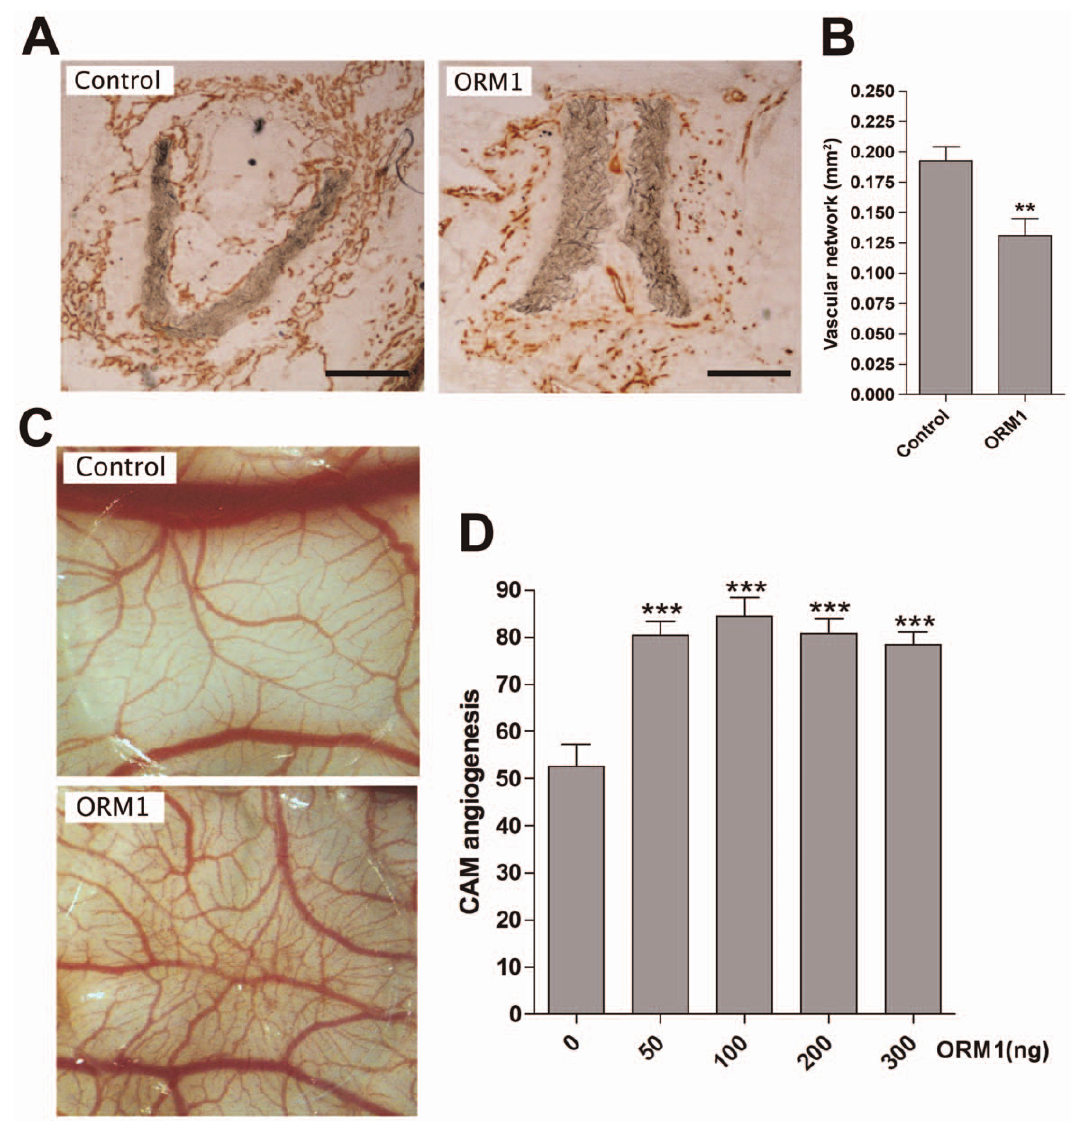
Figure 7. Effect of ORM1 on angiogenesis in the invivo aortic ring and CAM assays. (A). Frozen sections of subcutaneously implanted aortic rings stained by immunoperoxidase for CD31 show fewer microvessels in ORM1-primed implants compared to control. (B). Quantitative analysis shows 32% reduction in angiogenesis in ORM1-primed implants (N=12; **=p , 0.01). (C). Representative image of ORM1-treated CAM shows increased angiogenesis compared to control. (D). Quantitative analysis demonstrates 30% increase in blood vessels in CAMs treated with 50–300 ng ORM1 (N=15; ***=p , 0.001).